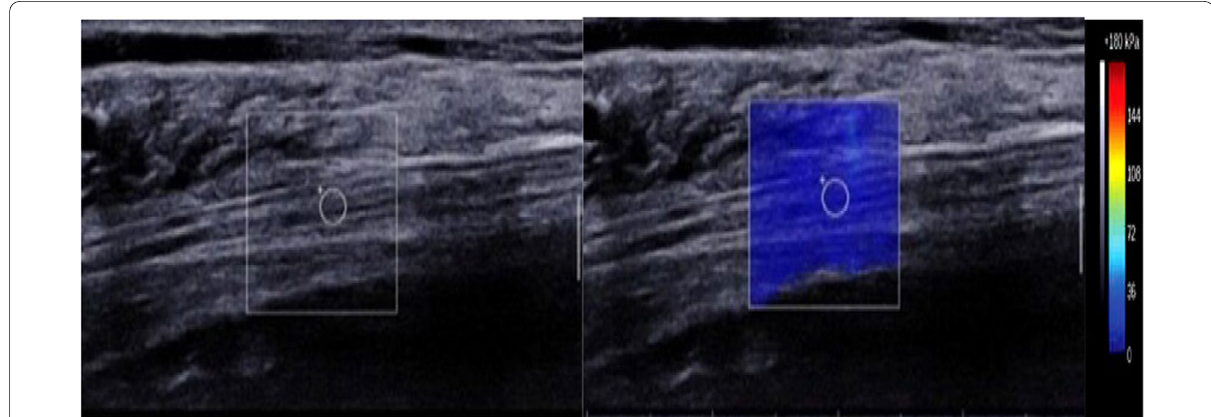
Fig. 2. 49 years old normal male (Left) high resolution ultrasound normal tibial nerve CSA ( homogenous blue color of the tibial nerve and mean tibial nerve stiffness value